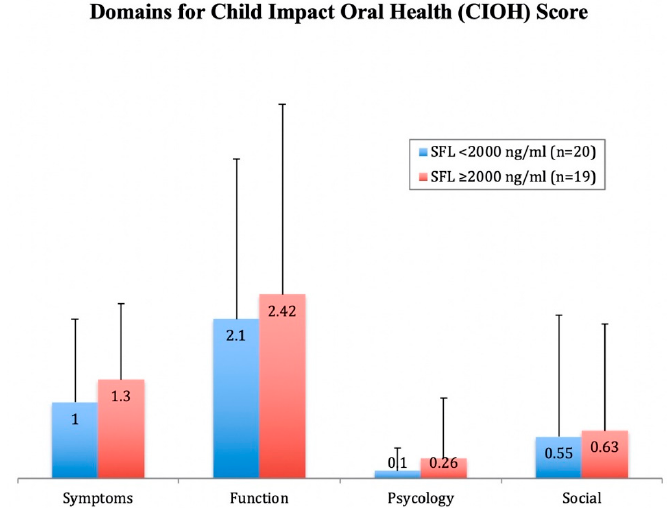
Figure 2. Bar-chart showing mean scores for the Child Impact Oral Health (CIOH) section domains in β -thalassemia major (BTM) participants with serum ferritin level (SFL) < 2000 ng / mL (n = 20) and with SFL ≥ 2000 ng / mL (n = 19). No significant di ff erences between the groups were detected using the Mann–Whitney U test ( p > 0.05).